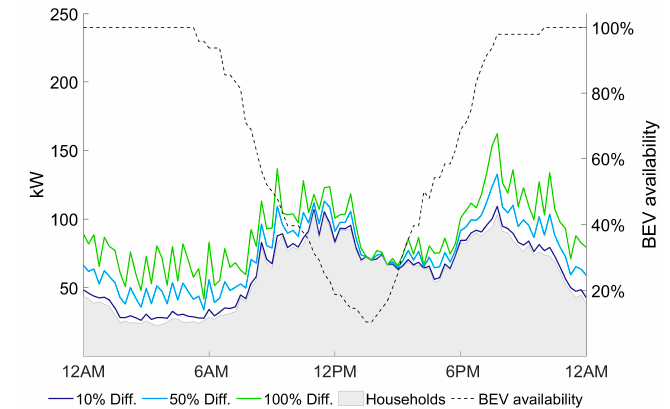
Figure 11. BEV charging demand at the home station under minimum charging capacity.